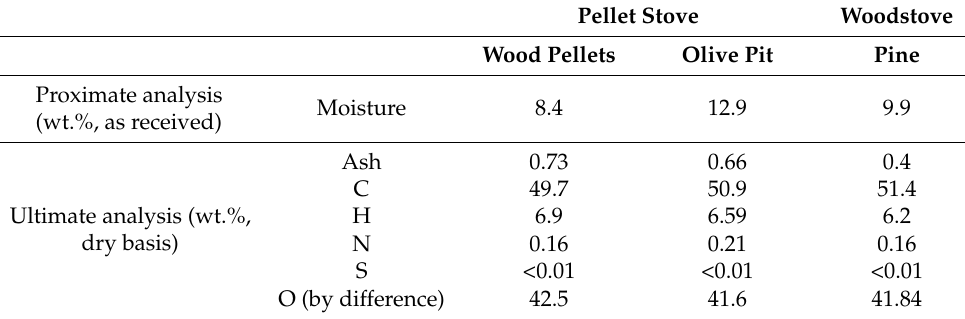
Pellet Stove Woodstove Wood Pellets Olive Pit Pine